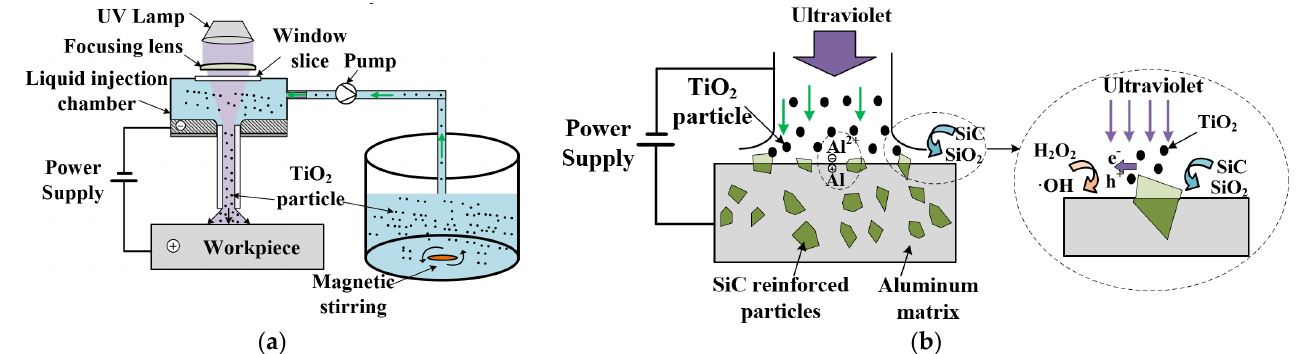
Figure 1. Photocatalytic−assisted jet electrochemical machining principle of composite SiC p /Al ( a ) Schematic diagram of PAJECM; ( b ) Processing principle.